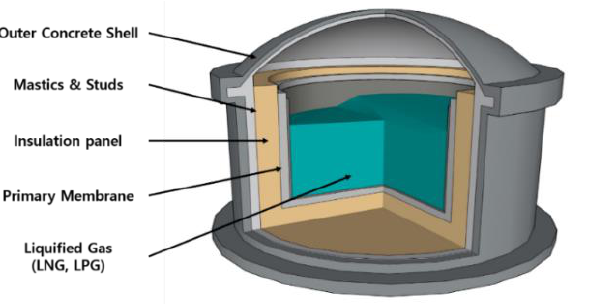
Figure 2. Approximate schematic diagram of a common storage tank (LNG and liquefied petroleum gas (LPG)).